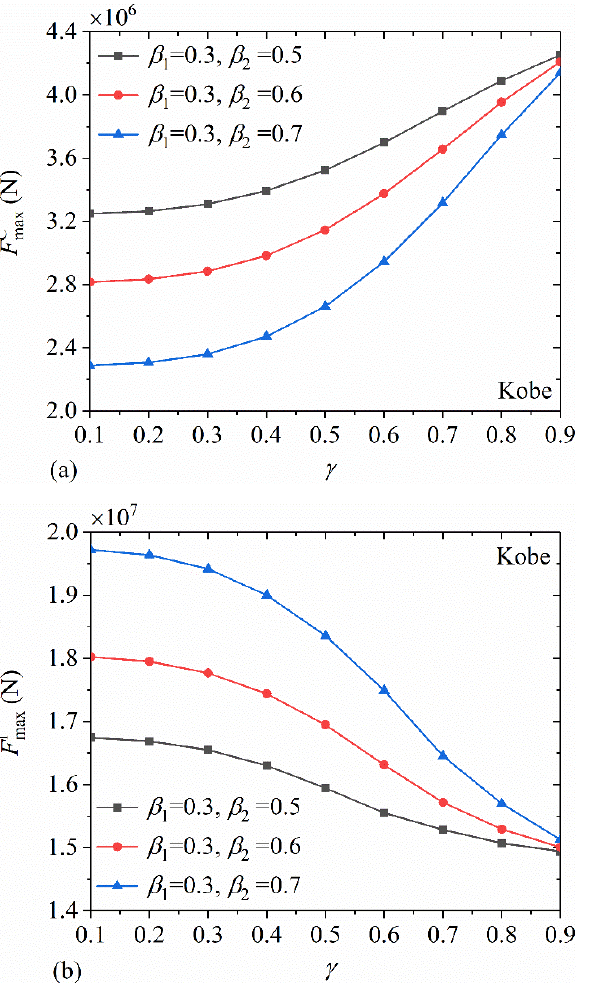
Figure 12. The maximum of the hydrodynamic response for the upper baffle height β 2 : ( a ) the shear force F max ; ( b ) the overturning moment M max .